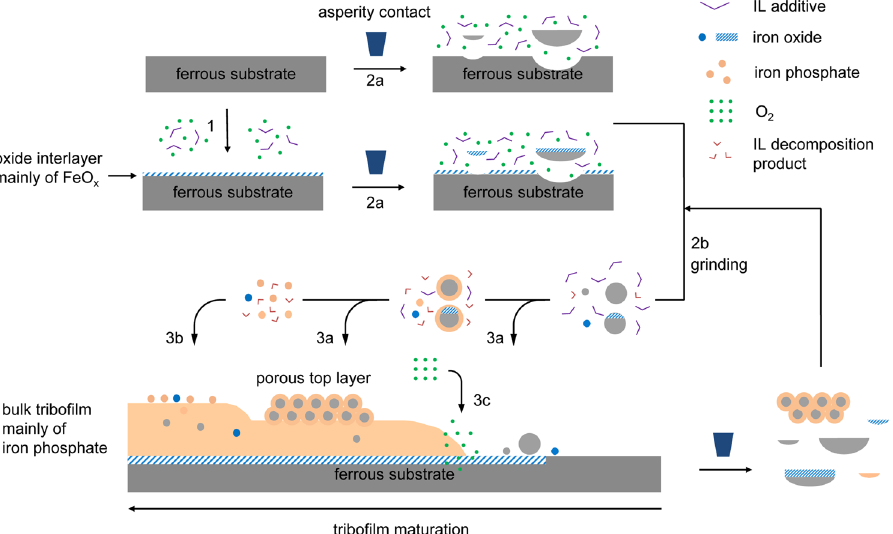
Figure 6. Proposed wear debris evolution and tribofilm growth for a ferrous substrate lubricated by an IL- containing lubricant. (1) Tribofilm initiation via direct surface reactions to generate an oxide interlayer mainly of iron oxide; (2) wear debris generation by (2a) asperity collisions, followed by (2b) breakdown through grinding process; (3) tribofilm growth via (3a) mechanical deposition, (3b) chemical deposition, and (3c) oxygen diffusion. Equilibrium eventually is reached between the tribofilm growth and